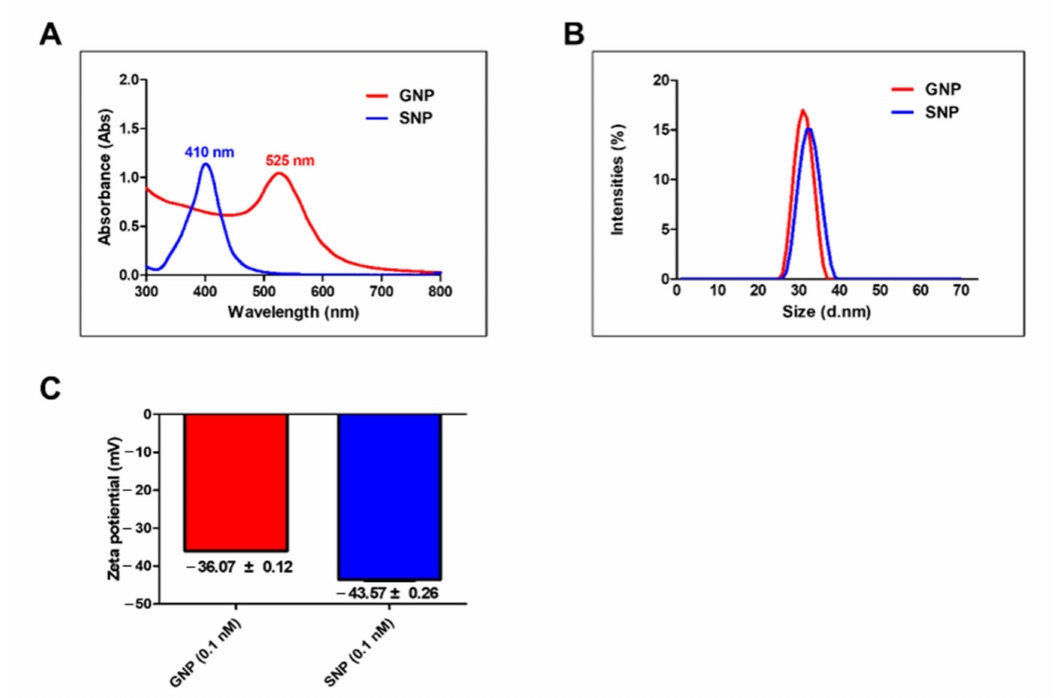
Figure 1. Characterization of gold nanoparticles (GNPs) and silver nanoparticles (SNPs). ( A ) Absorbance values ranged from 300 to 800 nanometer (nm) for the GNPs and SNPs. ( B ) Dynamic light scattering (DLS) analysis of the average diameter sizes of the GNPs and SNPs. ( C ) Zeta potential measurements of GNPs and